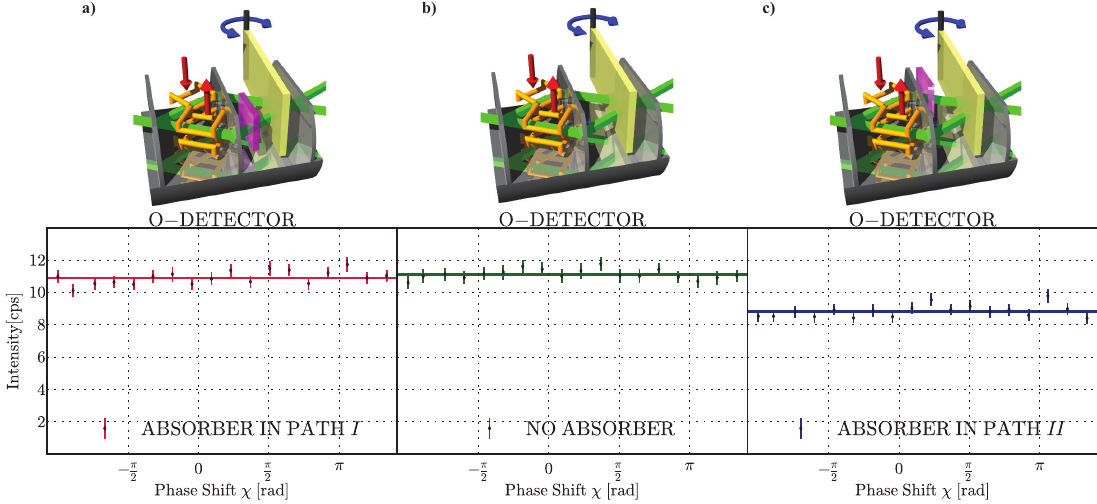
Figure 5. Measurement of (cid:104) ˆ Π I (cid:105) w and (cid:104) ˆ Π II (cid:105) w using an absorber. The intensity is plotted as a function of the relative phase χ . The solid lines represent least-square fits to the data and the error bars represent one standard deviation ( a ) an absorber in path I; no significant loss in intensity is recorded; ( b ) a reference measurement without any absorber; ( c ) an absorber in path II: the intensity decreases. These results suggest that for the successfully post-selected ensemble, the neutrons behave as going through path II.